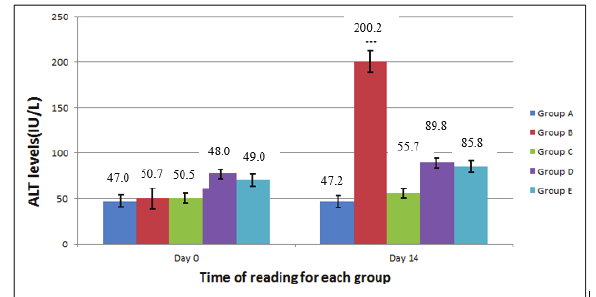
Fig-1: Effect of Ajwa date on ALT (mean ± SD) of ATT induced hepatotoxic rabbits (n=6) Group A: Normal Control, Group B: Anti-tuberculous drugs (ATT), Group C: ATT + Whole Ajwa Date, Group D: ATT + Ajwa Date Flesh, Group E: ATT + Ajwa Date Seed Powder ***p value < 0.001 vs All other groups